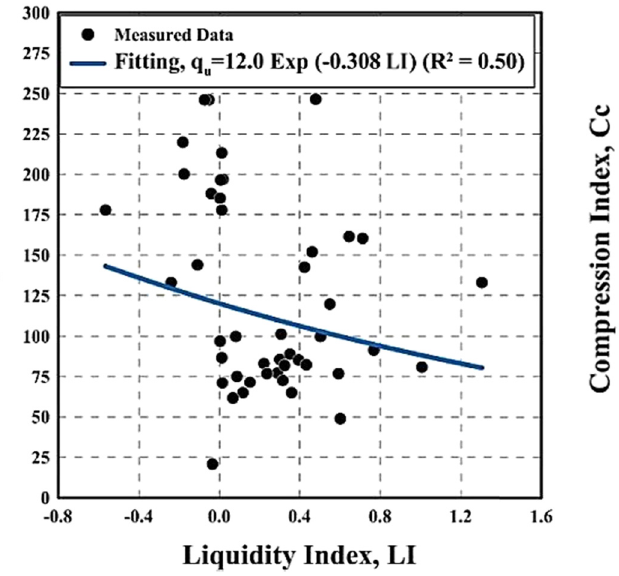
Figure 17: Compression index versus LL relationship. Figure 15: Uncon fi ned compressive strength versus LI